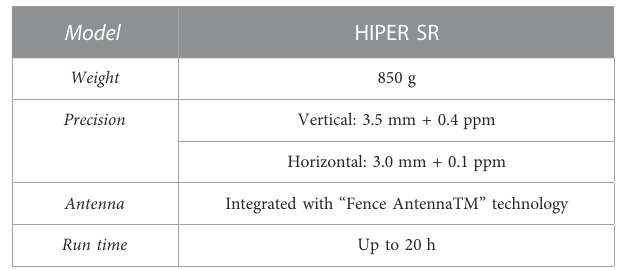
TABLE 5 GNSS receiver ’ s speci fi cations.